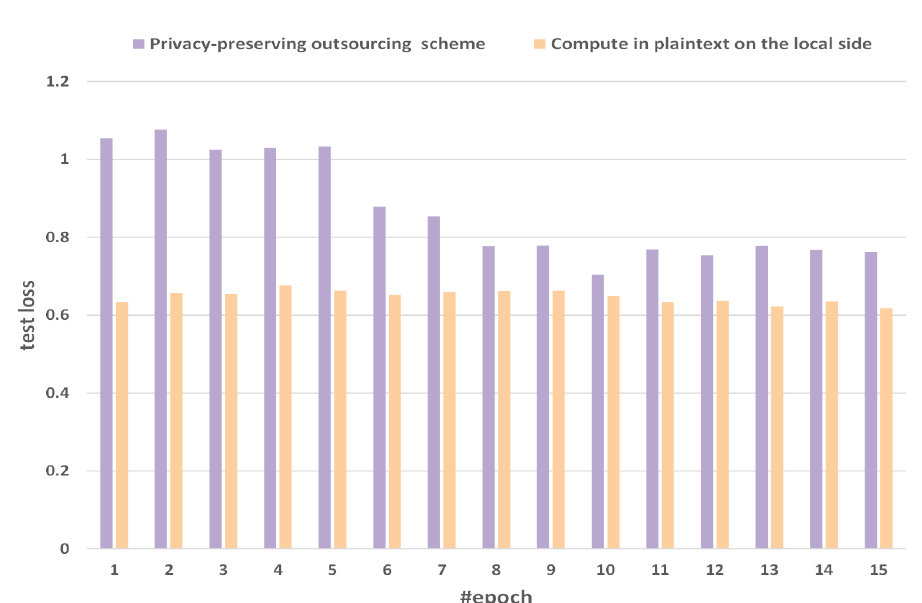
Figure 9. Comparison of test loss between the method of computing in plaintext on the local side and our scheme.